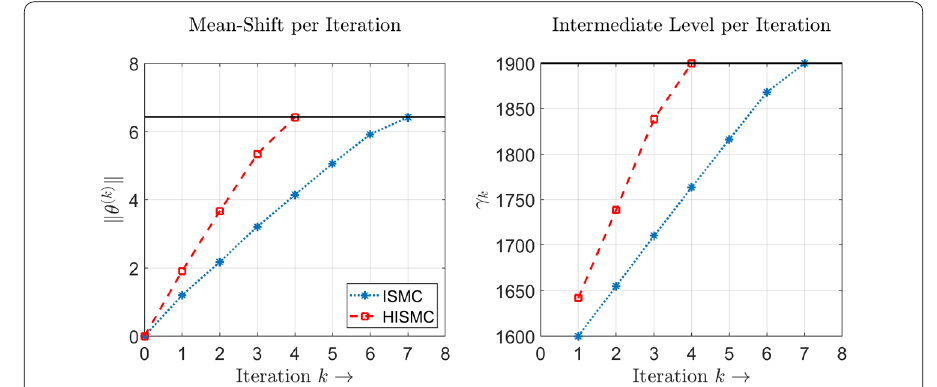
Figure 3 VCO: The mean-shifts θ ( k ) and intermediate levels γ k at iteration k